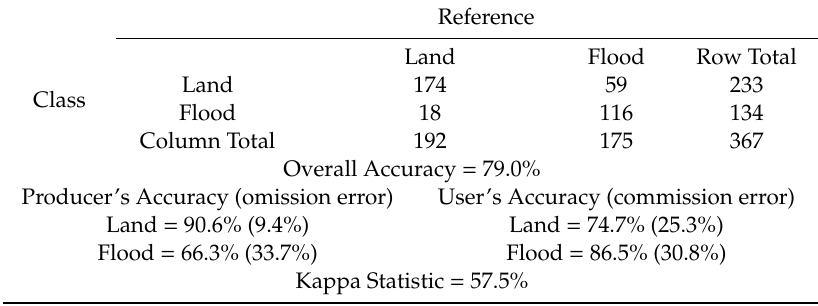
Figure 8. Gatineau: ( a ) High-resolution natural colour image from GoogleEarth TM ; ( b ) urban flood extents derived from a Pleiades-1B NIR image acquired on April 28, 2019; ( c ) urban flood extents